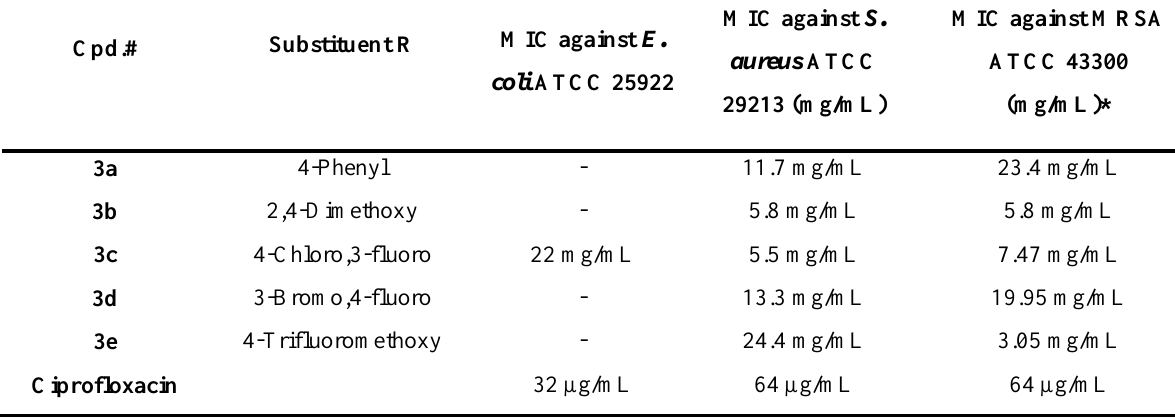
Table 1. MIC of test compounds